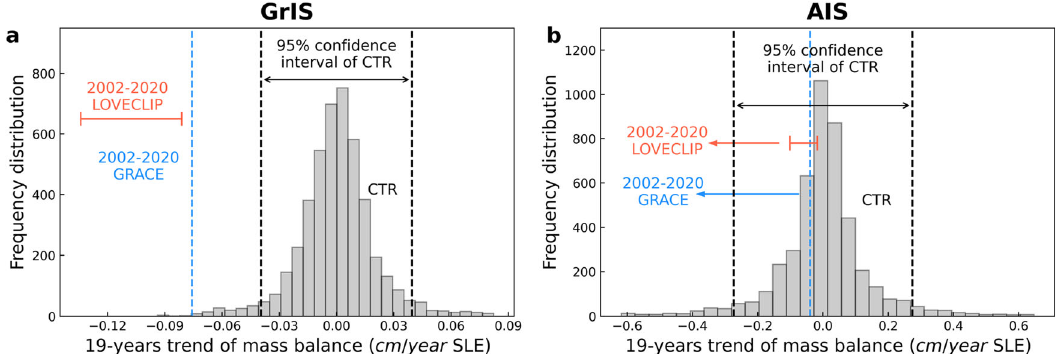
Fig. 1 | 19-year trends of observed and simulated mass balance of Greenland ice-sheet (GrIS) and Antarctic ice-sheet (AIS). a Histogram of each extracted 19-year trend of Greenland mass balance after 80-year-high-pass fi ltering in the 5000-year-long pre-industrial control run (CTR, gray histogram) with 95% con- fi denceintervalrangeofCTR(blackdashedline),andobservedestimatesof19-year